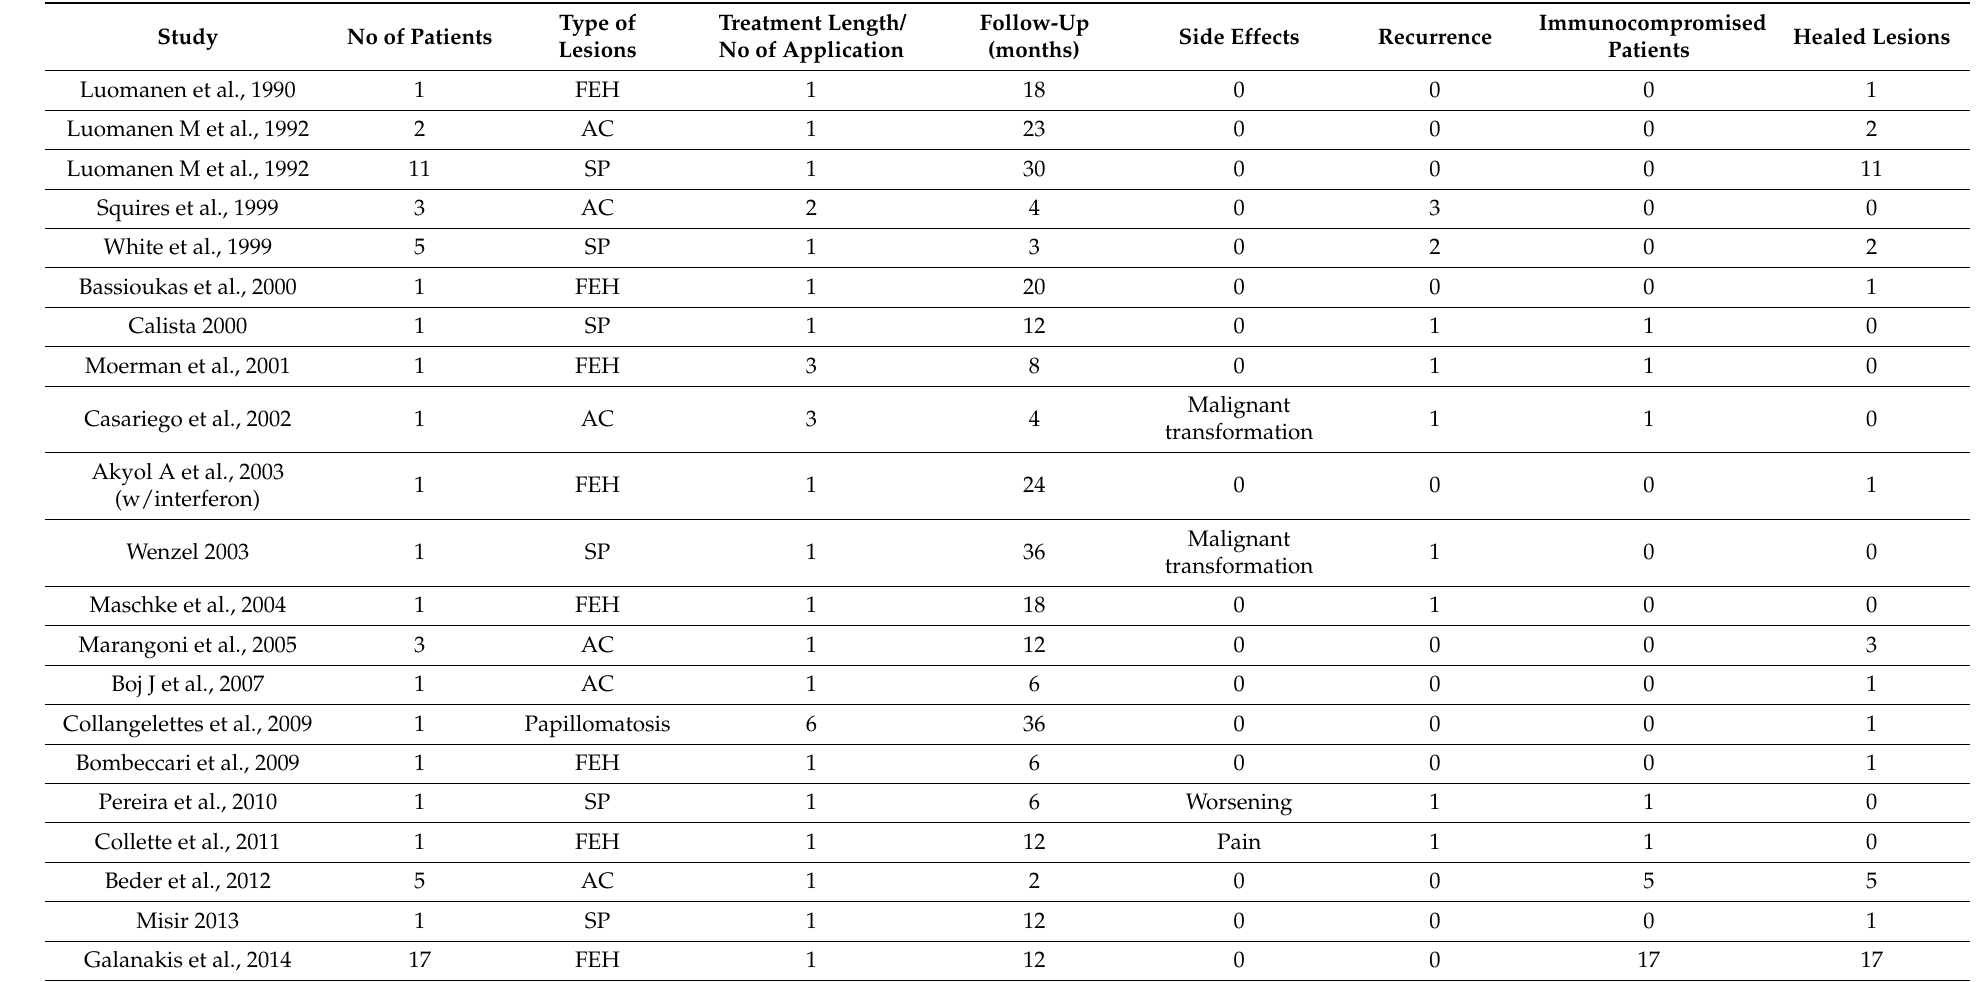
Table 13. Laser excision